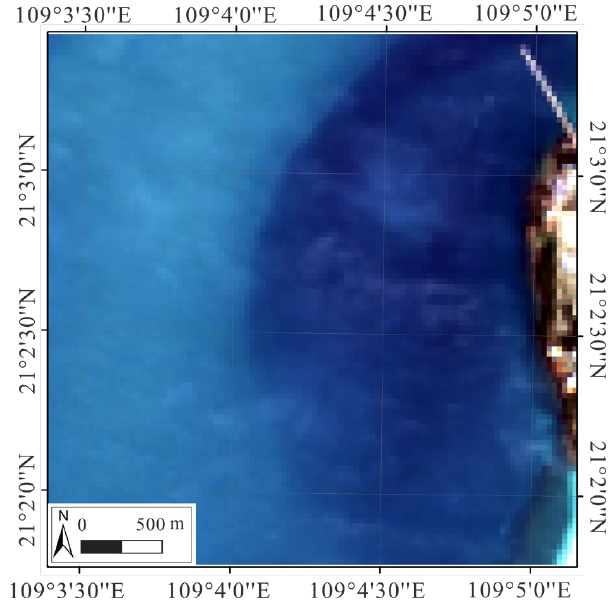
Figure 5. Landsat 8 true color satellite image.